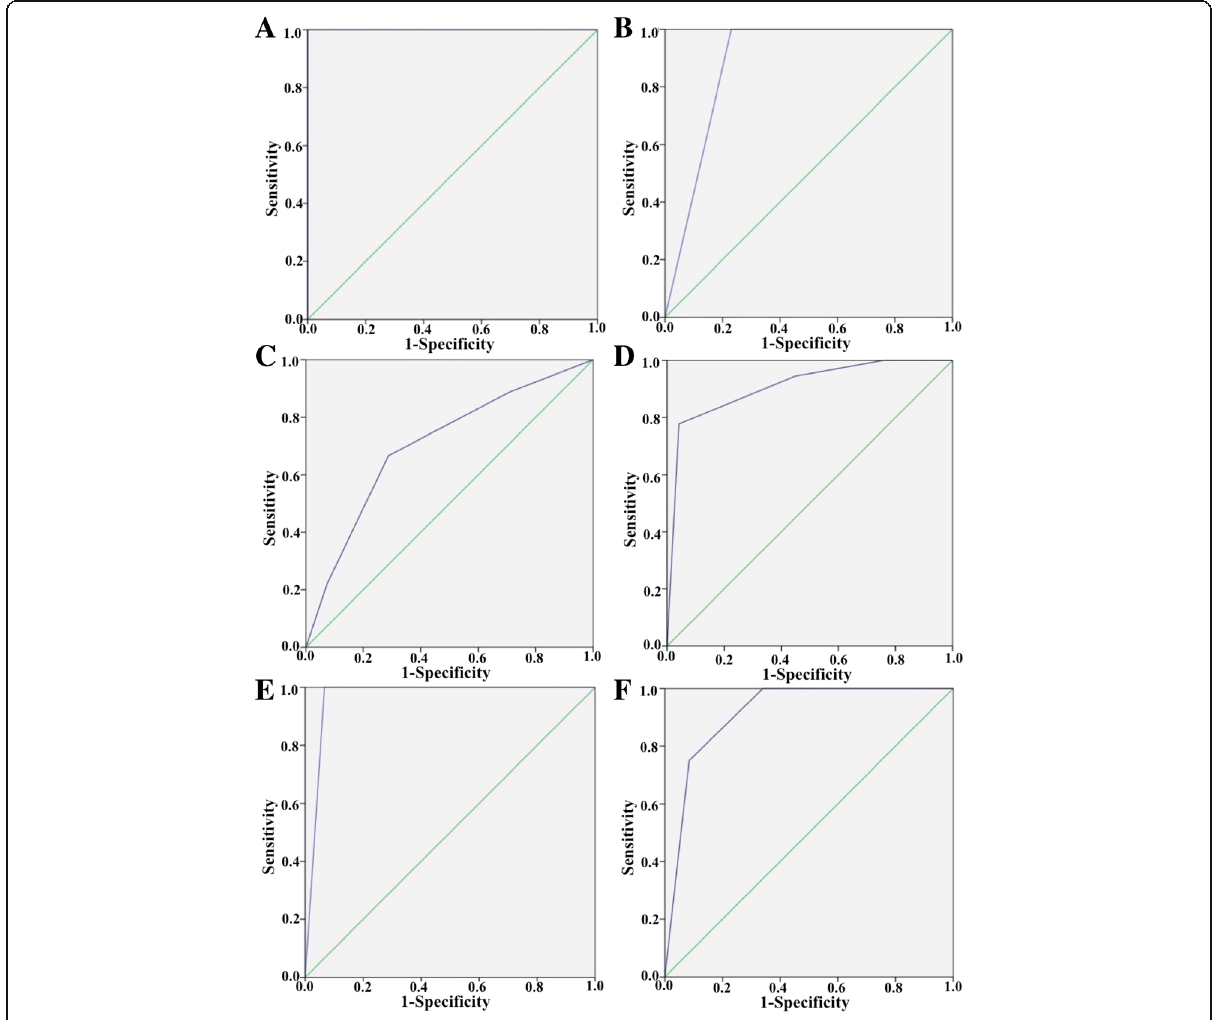
Fig. 3 ROC curve analysis of the positive predictability of biopsy specimens. a 1 tumor-containing fragment. AUC=1, P =0.099. b 2 tumor-containing fragment. AUC=0.885, P =0.194. c 3 tumor-containing fragment. AUC =0.705, P =0.045. d 4 tumor-containing fragment. AUC=0.909, P =0.039. e 5 tumor-containing fragment. AUC=0.978, P <0.001. f 5 tumor-containing fragment. AUC =0.915, P